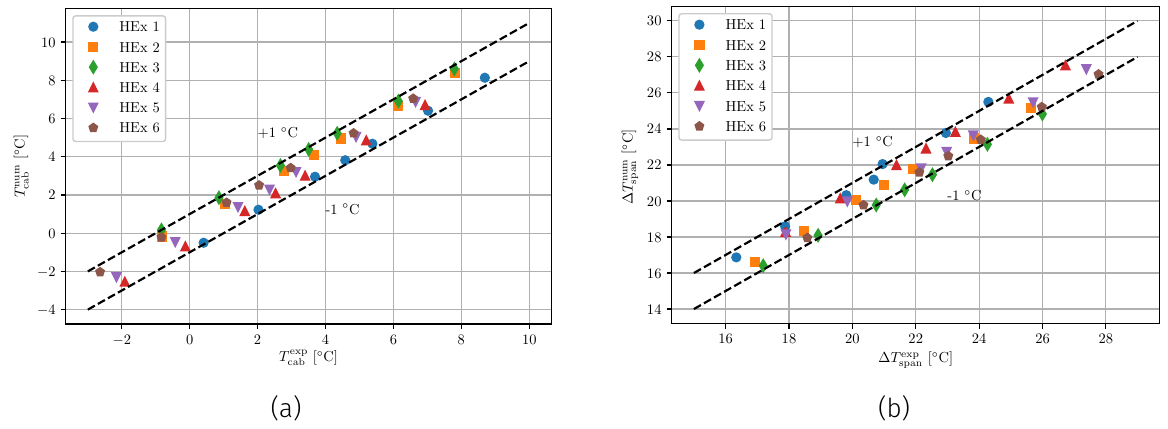
Figure 6. Comparison between the steady-state experiments performed for the six heat exchanger-fan combinations. (a) Average cabinet temperature; (b) Temperature difference between sources (temperature span). Note that the error bars associated with the temperature measurements are smaller than the markers and are, therefore, not